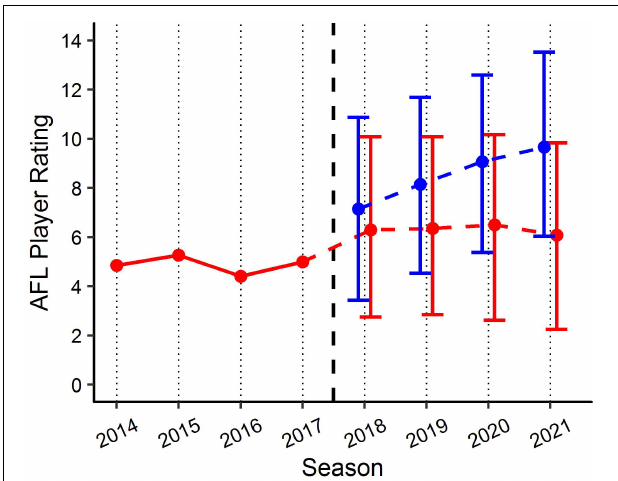
FIGURE 7 | Benchmark levels of AFL Player Ratings for two specific players using the age linear mixed model. Red line represents actual performance prior to 2017. Red and blue lines indicate player specific expectations ( ± 90% PI) of performance from 2018 for each player. Black x -axis intercept line indicates point of comparison.